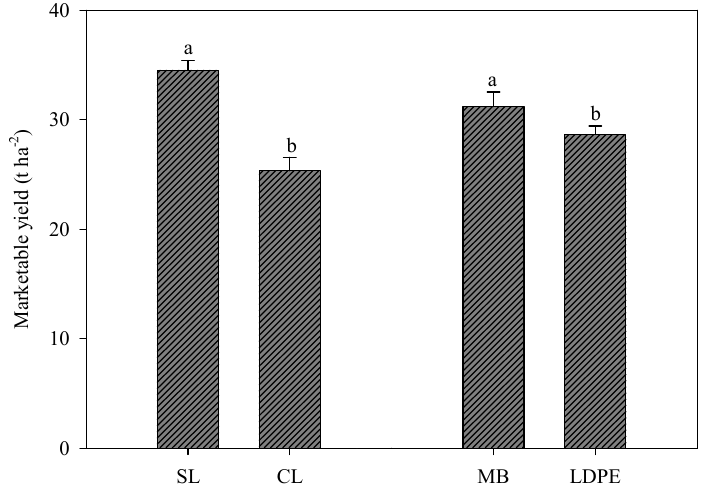
Figure 2. Marketable yields of muskmelon affected by soil texture (clay–loam—CL; sandy loam—SL) and mulching (biodegradable film—MB; polyethylene—PE). The vertical bars show the standard error; different letters indicate statistical differences.